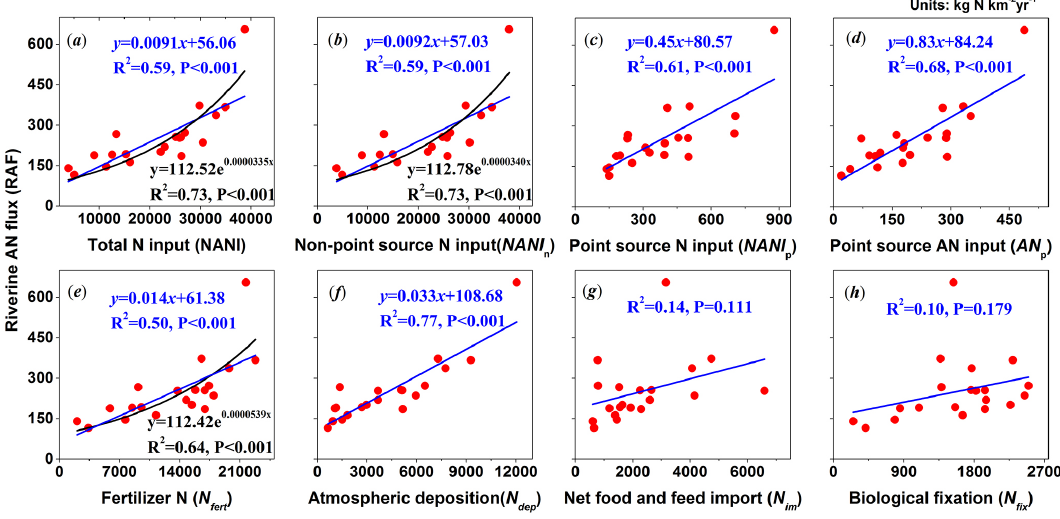
Figure 4. Linkage of AN flux with different N